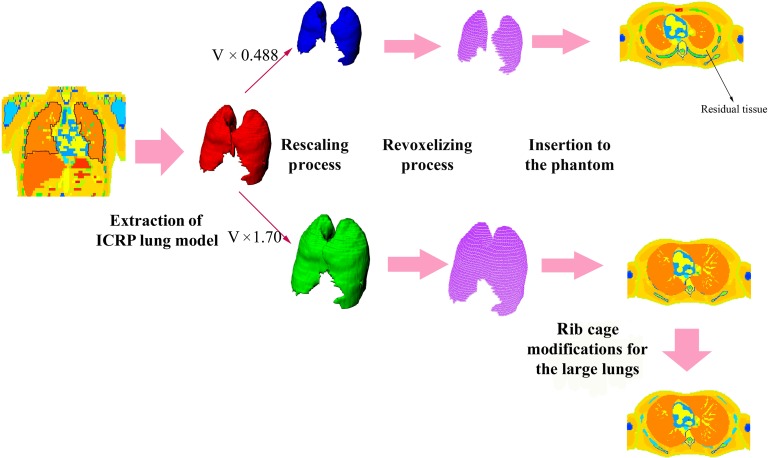
A schematic view of the development of phantoms with statistical lung masses. ICRP = International Commission on Radiological Protection; V = lung volume.